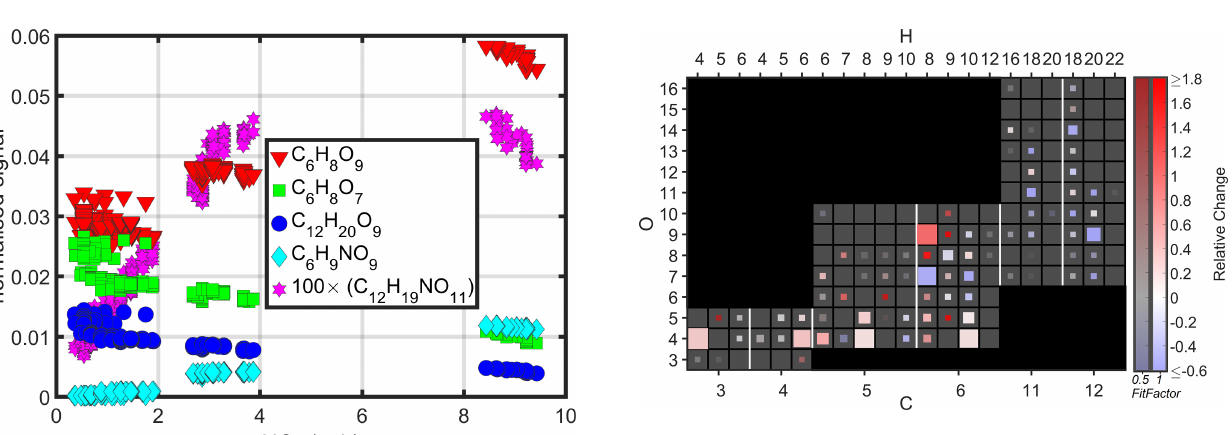
Figure 3. The effect of NO x on observed signals of molecules that do not contain nitrogen. Signals from when NO x concentration was 9ppb are compared to signals during no NO injection (with small NO x residual of < 0.9ppb). The bottom x axis shows the carbon number of each compound, with the white vertical lines separating the different C-atom numbers. The top x axis shows the hydrogen number, and the y axis the oxygen number. Compounds with an odd number of H atoms are radicals. Marker colour corresponds to the relative change in the signal size, when moving from zero NO x to high NO x ; marker size describes the size of the signal at zero NO x ; and the marker transparency describes the quality of the peak fit (if FitFactor = 1, marker is fully opaque; if FitFactor ≤ 0, marker is fully transparent). The two colour bars show the colour scale with two different opacities (0.5 and 1). Some products had values outside the colour axis limits. (C 6 H 9 O 5 , C 6 H 9 O 9 and C 11 H 18 O 11 being only such products with FitFactor values of 0.7 and above, experiencing relative changes of 3.6, 4.8 and − 0 . 7,